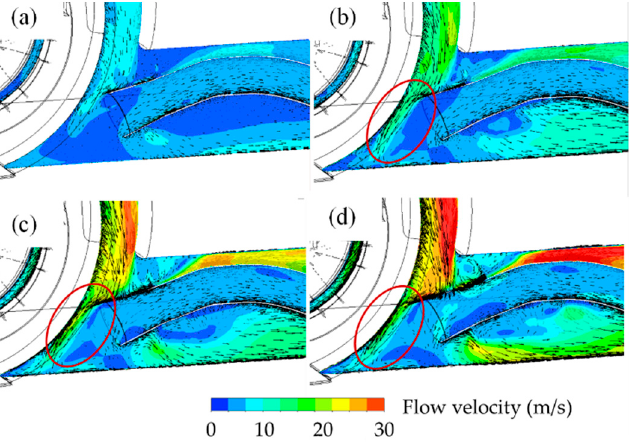
Figure 6. Flow profile behind the tire road contact for ( a ) 30 km/h, ( b ) 60 km/h, ( c ) 90 km/h, and ( d ) 120 km/h.